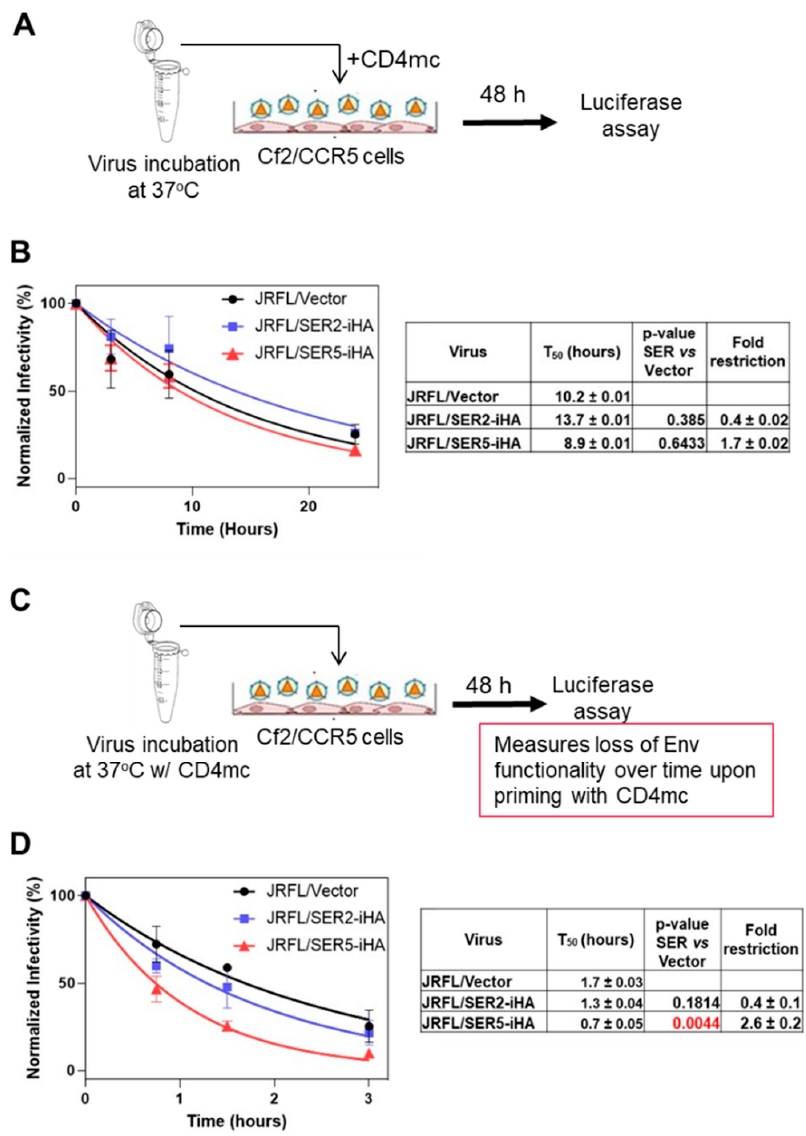
Figure 3. CD4 mimetic BNM-III-170 selectively accelerates the infectivity decay of HIV-1 JRFL pseudoviruses containing SER5. ( A ) A diagram of the rate of decay experiments related to panel B. Briefly, JRFL HIV-1 pseudoviruses lacking or containing SER5-iHA or SER2-iHA were incubated at 37 °C, 5% CO 2 for various durations. Prior to infection of Cf2/CCR5 cells, 20 μ M BNM-III-170 (CD4mc) was added to each sample, and the luciferase signal was measured 48 h post-infection. ( B ) The rates of infectivity decay of JRFL HIV-1 pseudoviruses lacking or containing SER5-iHA or SER2-iHA. The plotted data are means and S.D. from two independent experiments performed in triplicate. The T 50 (half-life) values calculated by single-exponential decay fitting, statistical significance of SER-iHA effect on the JRFL rate of decay (ANOVA repeated measures test), and the fold restriction are listed in the table on the right. ( C ) A diagram of the assay to measure the Env inactivation kinetics in the presence of CD4mc. The JRFL pseudoviruses were incubated at 37 °C, 5% CO 2 for various durations in the presence of 20 μ M BNM-III-170 (CD4mc), followed by inoculation of Cf2/CCR5 target cells. The resulting infection was measured after 48 h wish a luciferase assay. ( D ) The graph shows the result of infectivity decay fitted with a single-exponential function. Data are means and S.D. of three independent experiments, each performed in triplicate. Table on the right lists the T 50 values and statistical significance (ANOVA repeated measures test), as well as fold-restriction of JRFL virus by SER2-iHA and SER5-iHA.